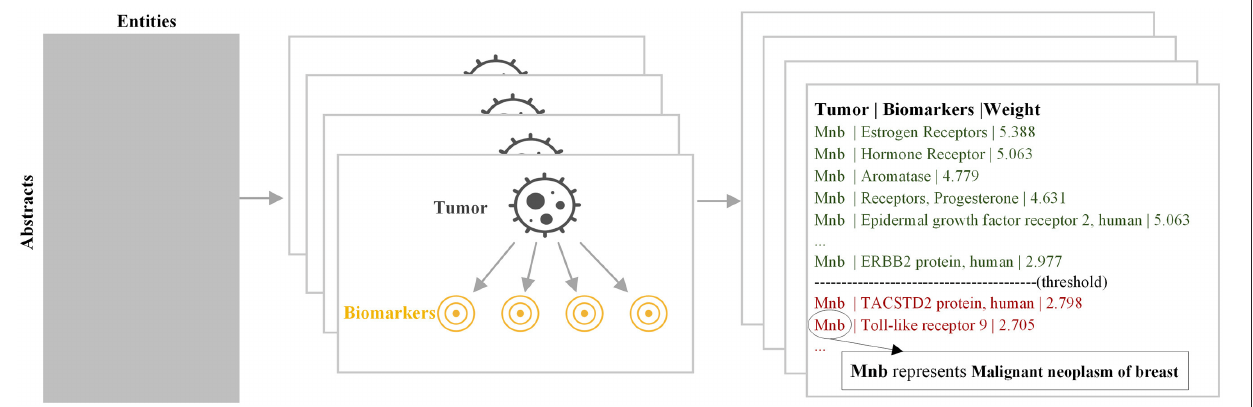
FIGURE 3 | Workflow of modeling the relationship between diseases and biomarkers.